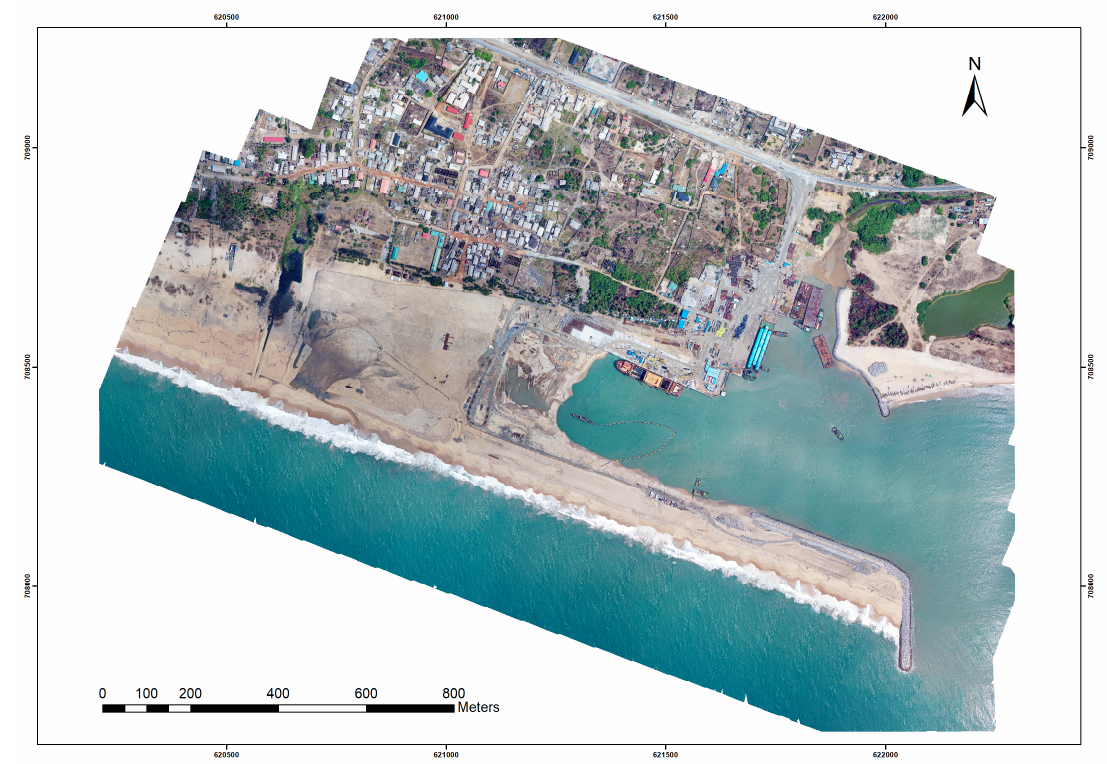
Figure 6. Orthophoto of March 2020, showing the ongoing expansion of the port basin. Image courtesy of CDR International B.V.